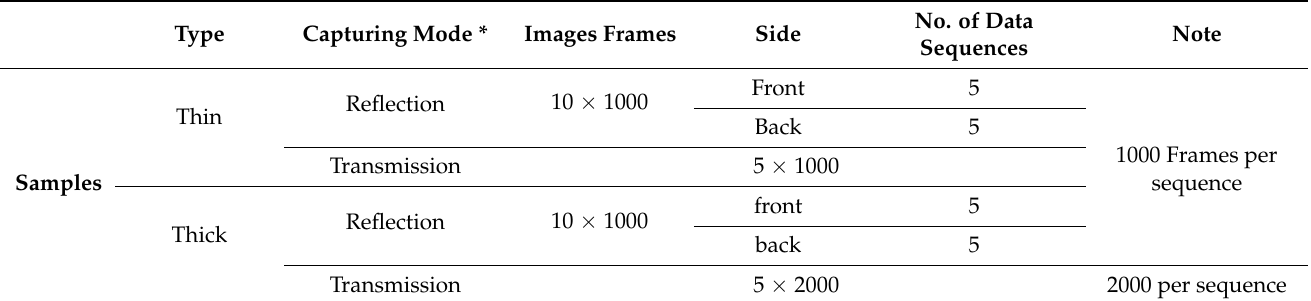
Table 4. Experiment